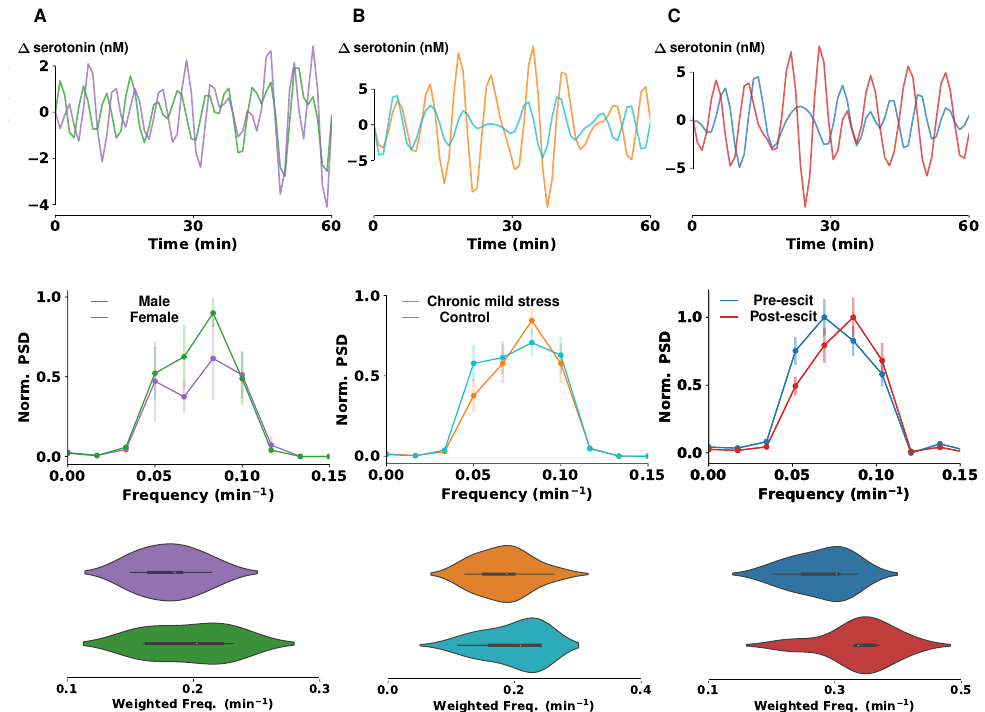
Figure 3. Spectral analysis and comparison of serotonin oscillations. ( A–C ) Representative examples of 60-min FSCAV serotonin acquisitions in the CA2 region of a mouse hippocampus. Each signal was band-pass filtered with a 3 rd order Butterworth filter, with cutoff frequencies of 0.0008 Hz and 0.005 Hz. The power spectrum of each acquisition was then computed and the average and SEM across animals is represented in the center panels. ( A ) shows differences in the PSD of male and female mice (n = 5 animals in each group); ( B ) shows differences between mice that underwent a chronic mild stress paradigm and the control mice (n = 10 animals in each group); and ( C ) shows differences in PSD, pre- and post-escitalopram (escit) (10 mg/kg) administration, in mice (n = 5 animals). Power- weighted sum of frequencies were calculated for each power spectrum, and violin plots of their distributions for each dataset are shown